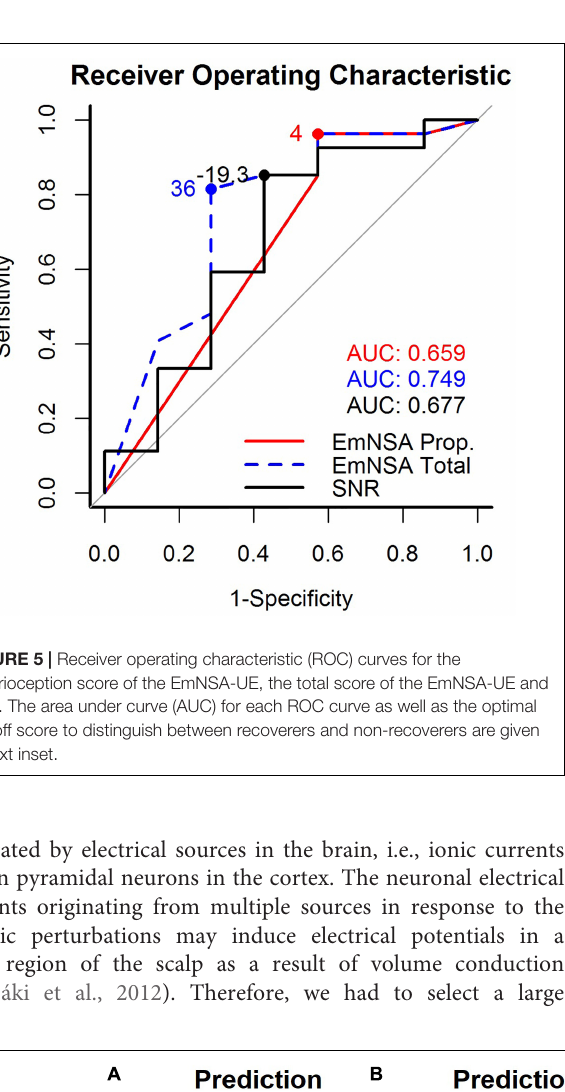
Frontiers in Human Neuroscience |